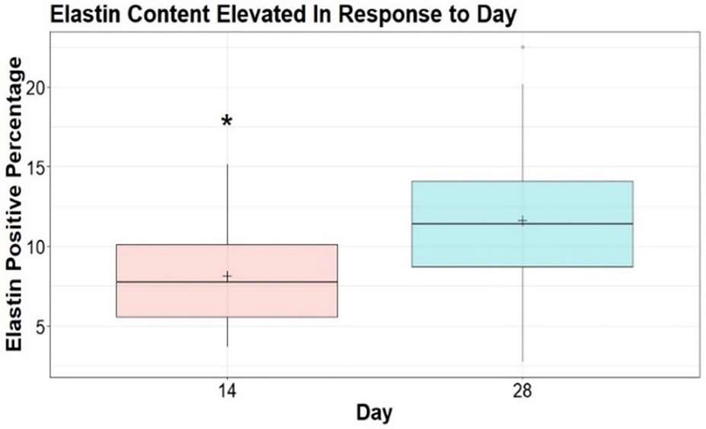
Analysis of elastin positive staining percentage between day 14 and 28. Asterisk represents significantly different group means where p=0.0003. Comparison was conducted using a two-sided t-test with equal variance (Levenne’s Test; p=0.08). Means are illustrated by crosses.